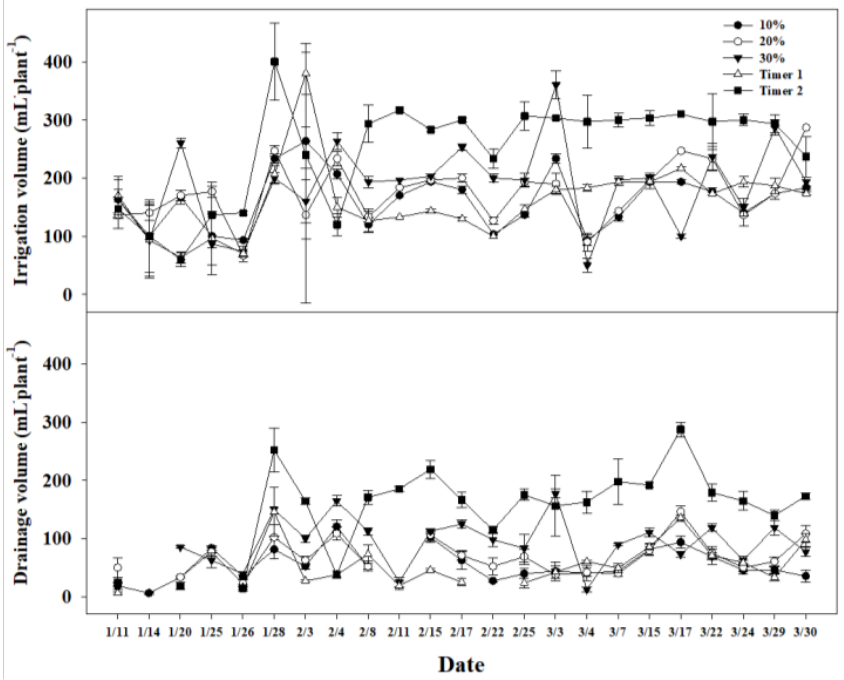
Figure 1. Changes in irrigation and drainage amounts of strawberry ‘Kuemsil’ affected by the nutrient solution supplying system using different drainage rate levels and timings (Drainage rate 10%, 20%, or 30%; Timer 1, timer set for 4 applications daily; Timer 2, timer set for 6 applications daily). Vertical bars indicate standard errors of the means ( n = 3).